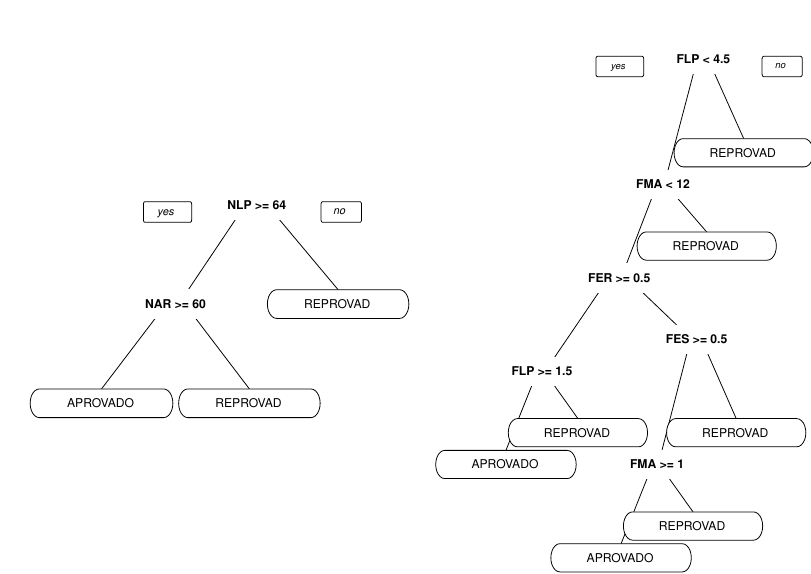
Figure 18. The tree grown using grade and absenteeism and results.